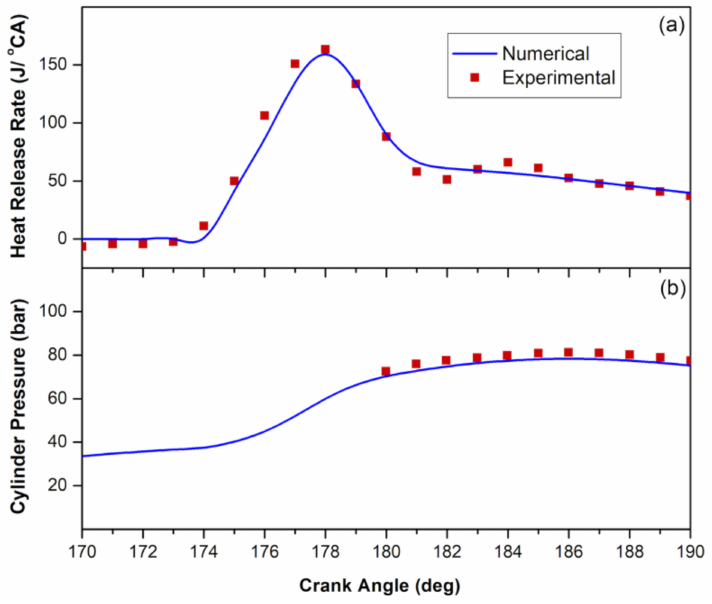
Figure 4. Comparison between numerical and experimental results: ( a ) heat rate release; ( b ) cylinder pressure.